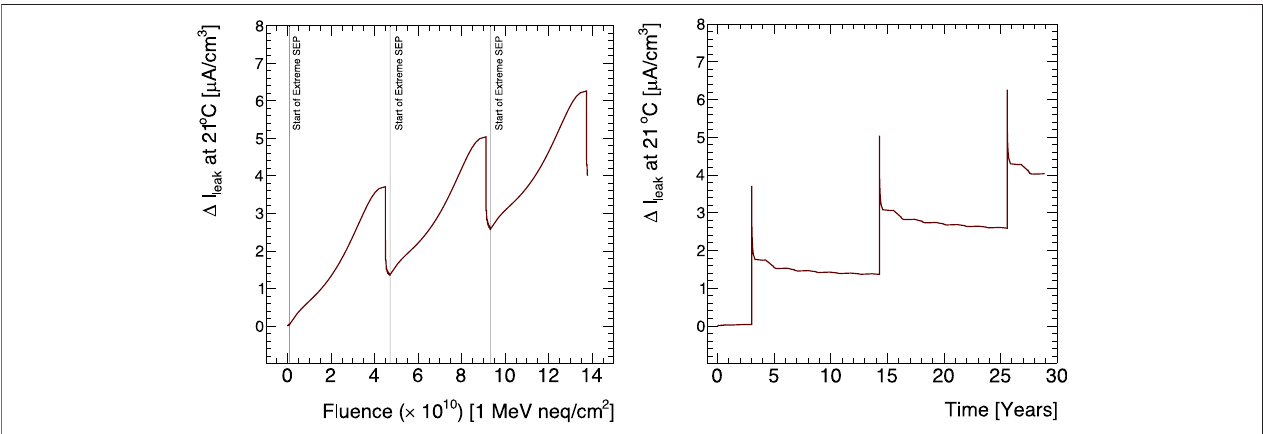
FIGURE4| Predictedchangeinleakagecurrentdensity asafunctionof (left) integratedchargedhadron fl uenceand (right) time inEarth-years, inboththen-type and p-type silicon sensors, normalized to 294 K.